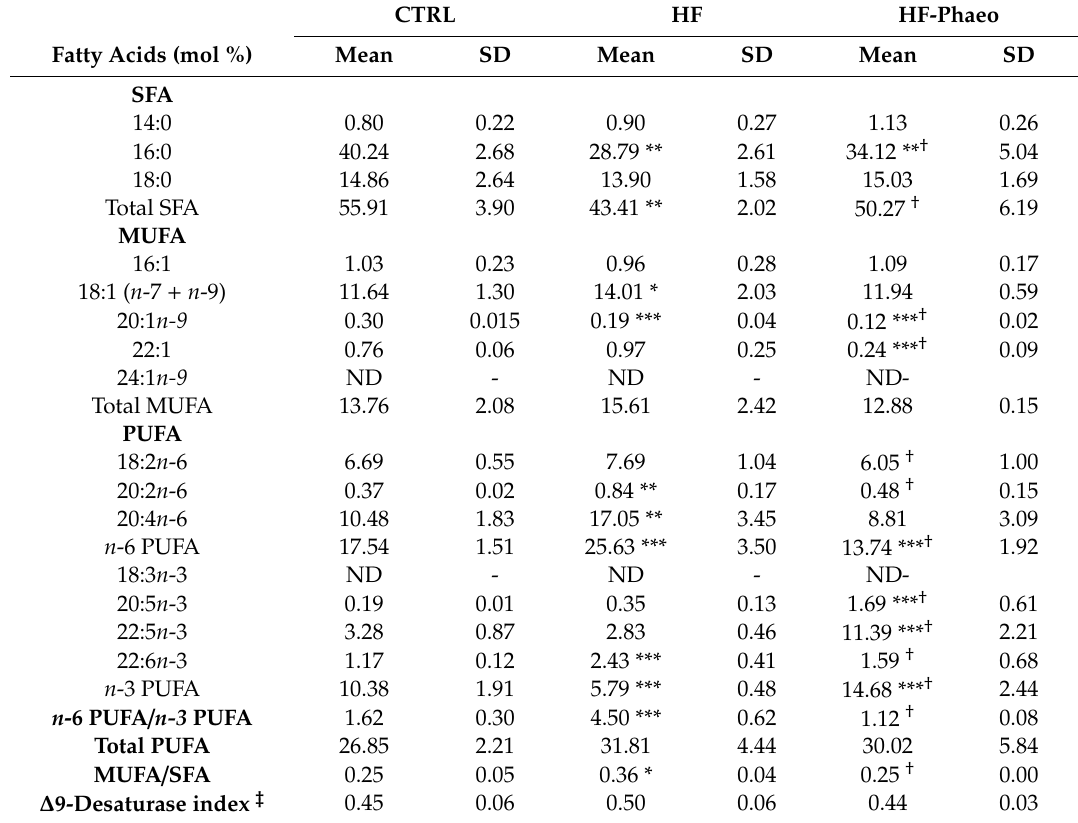
Table 3. Fatty acid composition of red blood cells